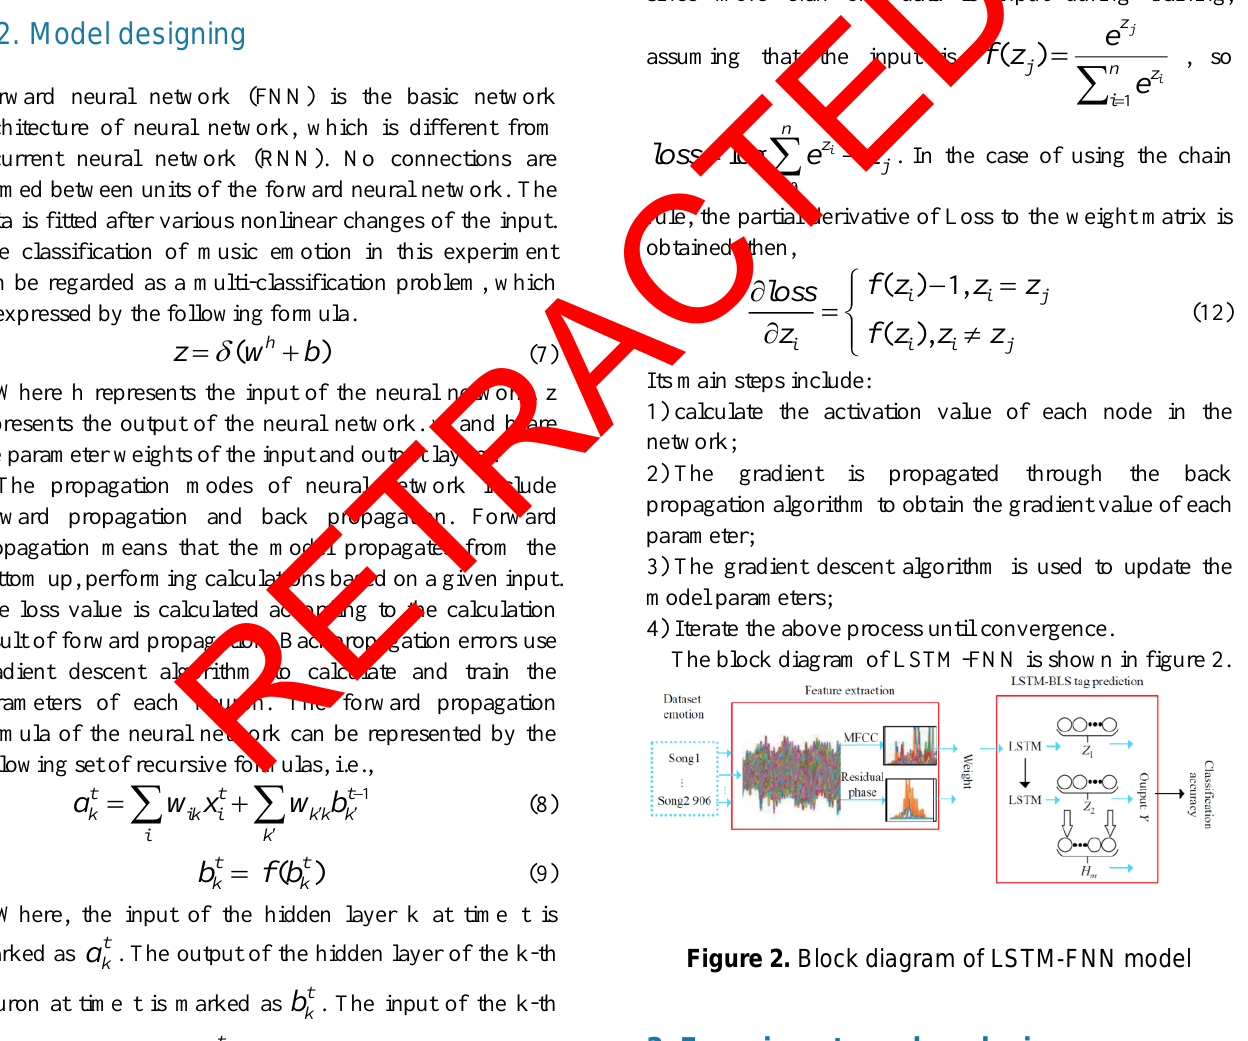
Figure 1. Flow diagram of feature extraction